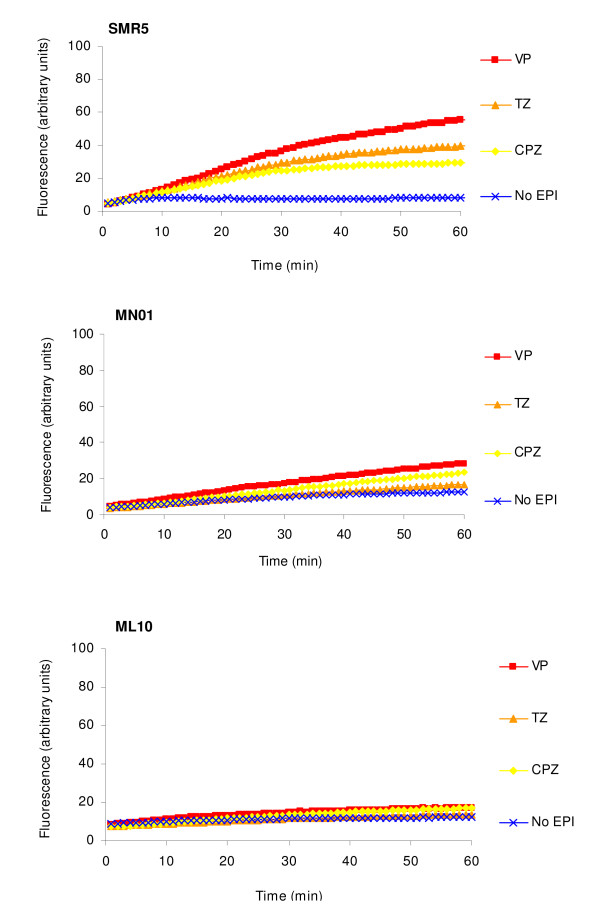
Effect of efflux inhibitors on the accumulation of EtBr at 1, 2 and 4 mg/L by M. smegmatis SMR5, MN01 (ΔmspA) and ML10 (ΔmspAΔmspC), respectively. CPZ, chlorpromazine; EPI, efflux pump inhibitor; TZ, thioridazine; VP, verapamil.